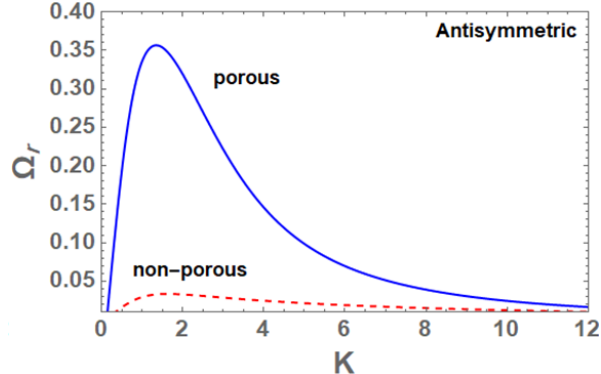
Figure 14. Non-dimensional growth rate Ω r and non-dimensional wave number K for both case of porous medium ( ε = 0.5; κ 1 = 2 ) , and non-porous medium ( ε = 1; κ 1 → ∞ ), when We = 2000; Oh = 2; N = 1; v = 0.2; ρ = 0.1; U = 1.5; ˜ (cid:101) l = 0.3; ˜ (cid:101) g = 0.1; E = 10; V (cid:48) = 5; for axisymmetric disturbance case.